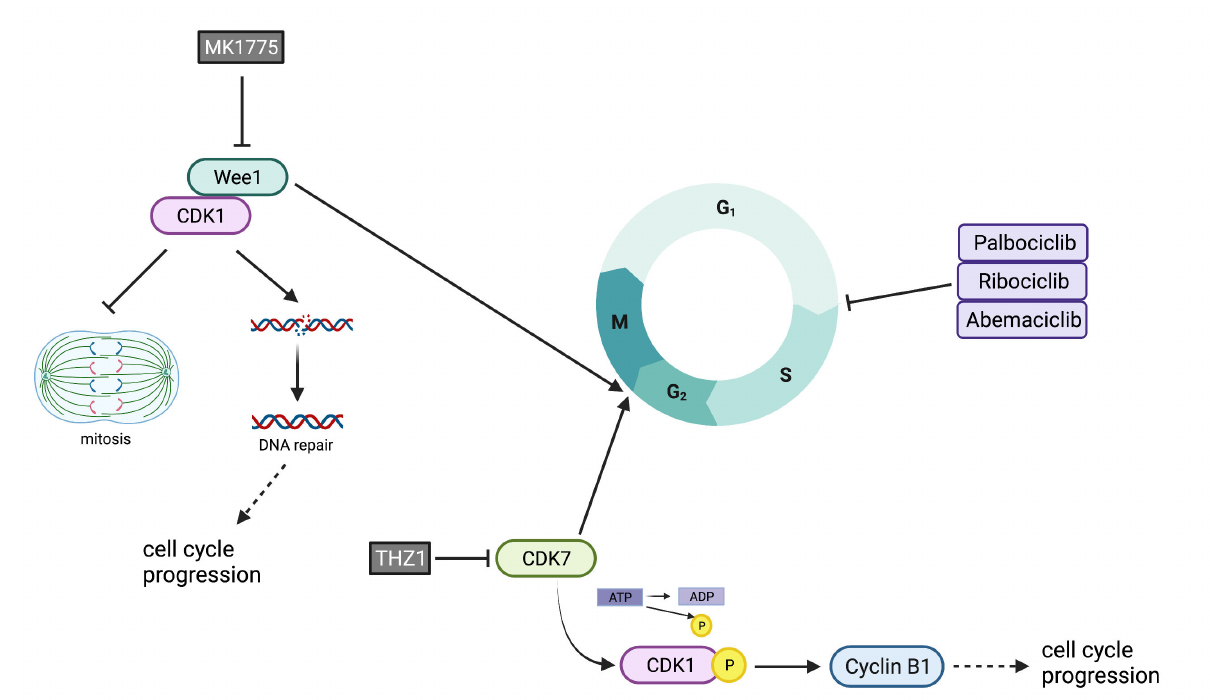
Figure 2. Increasing reliance on the G2/M checkpoint allows cells to bypass the G1/M deficiencies caused by CDK4/6 inhibitors. Wee1 works at the G2/M checkpoint to stall mitosis and induce DNA repair so that cells can progress in the presence of CDK inhibitors. MK1775 works here to inhibit the action of Wee1, thus preventing repair from occurring and so the cell cannot continue through division. Additionally, at G2/M, CDK7 phosphorylates CDK1 to cause cell cycle progression via cyclin B1. THZ1 is an agent that inhibits CDK7 to prevent this method of cell cycle